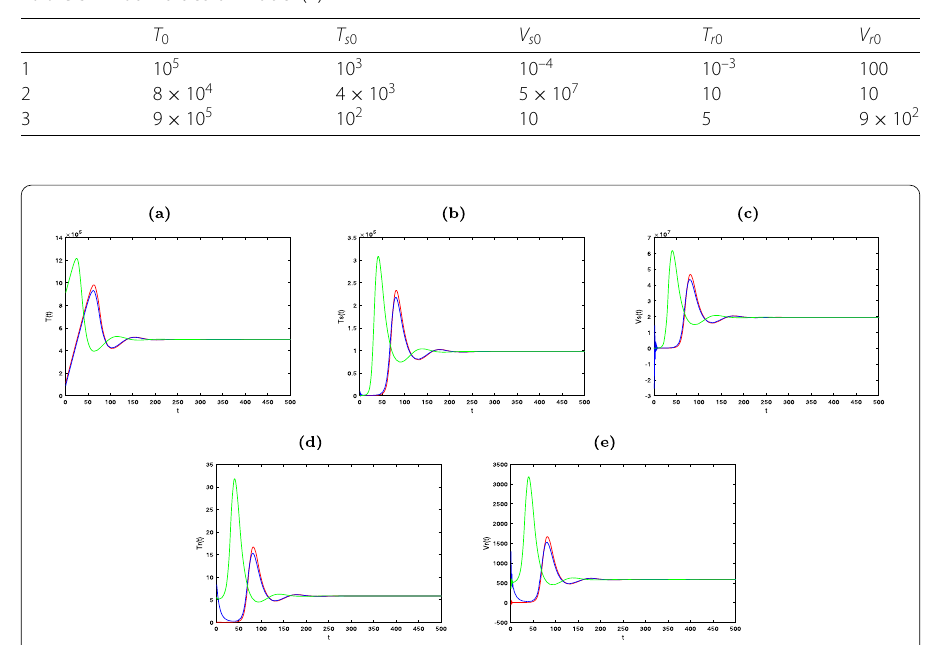
Figure 5 ( a ) Dynamical behaviors of uninfected target cells; ( b ) Dynamical behaviors of infected cells infected by wild-type virus; ( c ) Dynamical behaviors of drug-resistant virus; ( d ) Dynamical behaviors of infected cells infected by wild-type virus; ( e ) Dynamical behaviors of drug-resistant virus